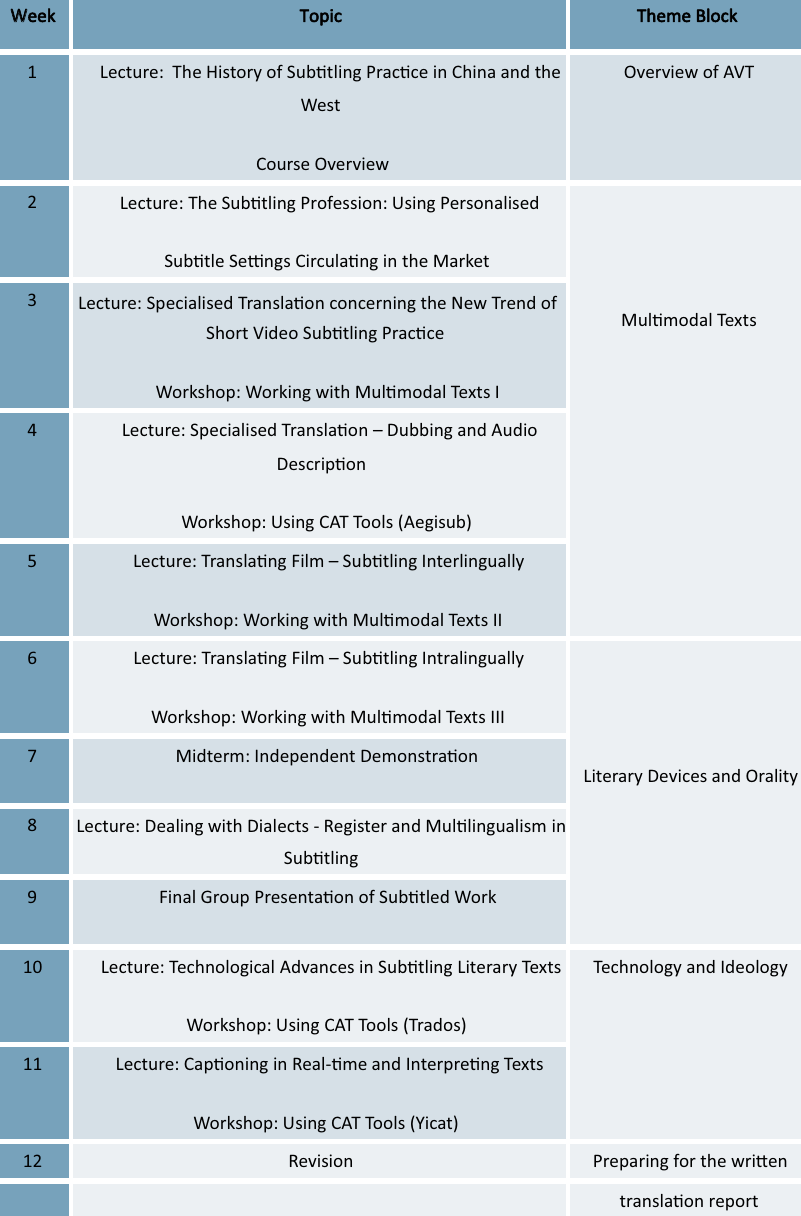
Fig. 7 The schedule for the subtitling course. This fi gure demonstrates the relevant topics incorporated into the discussions of subtitling endeavours in our